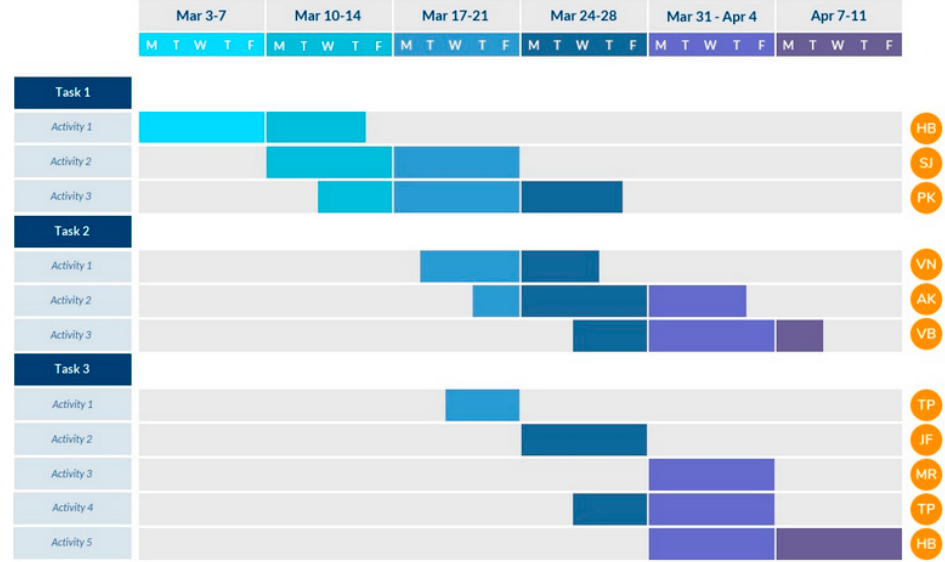
Figure 14. Process planning guideline.